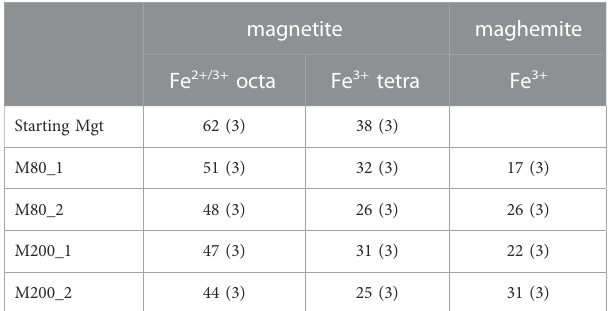
TABLE 2 Quantitative results of room temperature Mössbauer analyses for both duplicate experiments at 80 ° C and 200 ° C, expressed in at%. The uncertainty is 3 at%. For related Mössbauer spectra, see Figure 4. For related hyper fi ne parameters, see Supplementary Table S1.